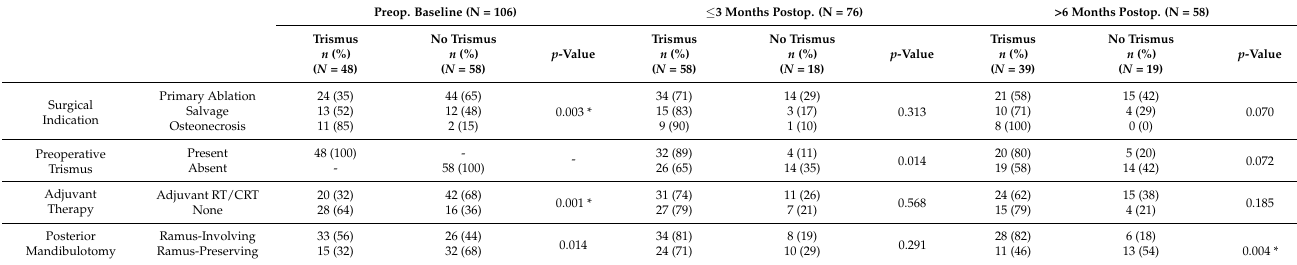
Table 2. Proportion of patients experiencing trismus at three timepoints: preoperative baseline, early postoperative period ( ≤ 3 months after surgery), and late postoperative period (>6 months after surgery). Preop.